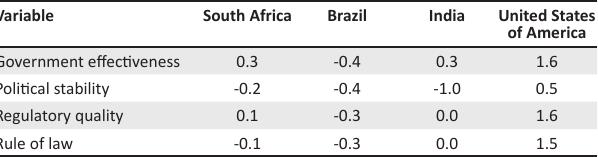
TABLE 1: Emerging economy indicators of South Africa, Brazil and India in comparison with the United States of America.